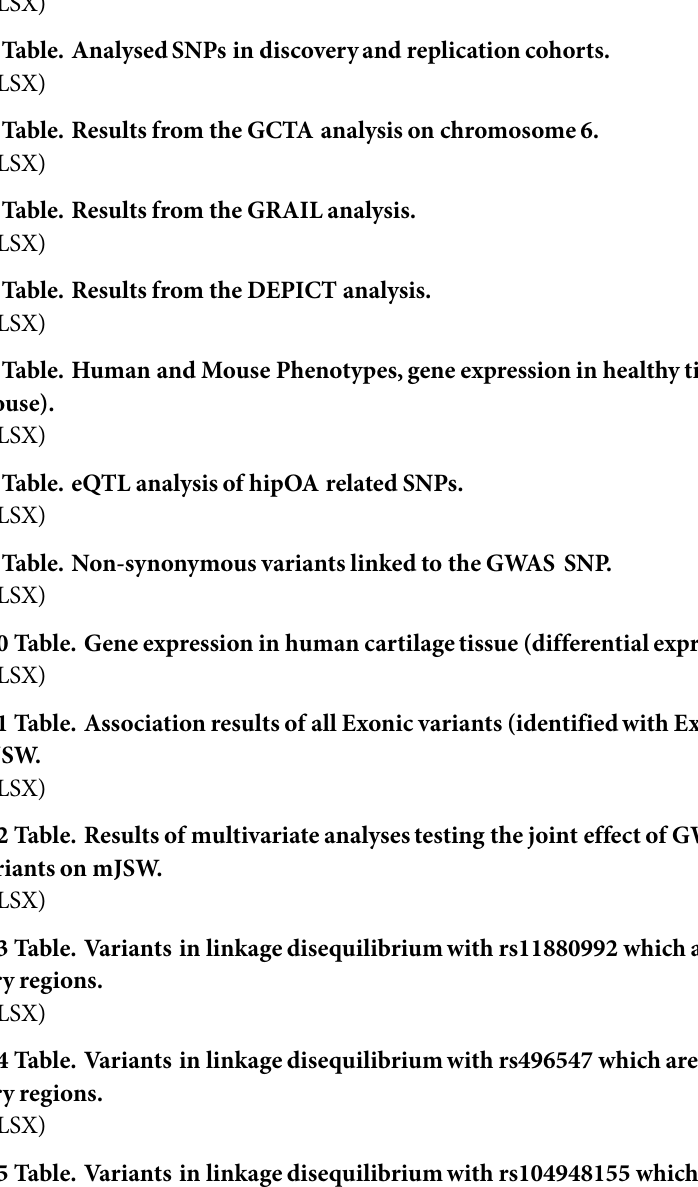
S1 Table. Baseline characteristicsof the studies included in the analyses of minimal Joint Space Width. S2 Table. Quality control and inclusion criteria. S3 Table. AnalysedSNPs in discoveryand replication cohorts. S4 Table. Results from the GCTA analysis on chromosome 6. S5 Table. Results from the GRAIL analysis. S6 Table. Results from the DEPICT analysis. S7 Table. Human and Mouse Phenotypes, gene expression in healthy tissue (human, mouse). S8 Table. eQTL analysis of hipOA related SNPs. S9 Table. Non-synonymous variants linked to the GWAS SNP. S10 Table. Gene expression in human cartilagetissue (differential expression) S11 Table. Association results of all Exonic variants (identifiedwith Exome-seq)and mJSW. S12 Table. Results of multivariate analyses testing the joint effect of GWAS hits and exome variants on mJSW. S13 Table. Variants in linkage disequilibriumwith rs11880992 which are located in regula- tory regions. S14 Table. Variants in linkage disequilibriumwith rs496547 which are located in regula- tory regions. S15 Table. Variants in linkage disequilibriumwith rs104948155 which are located in regu- latory